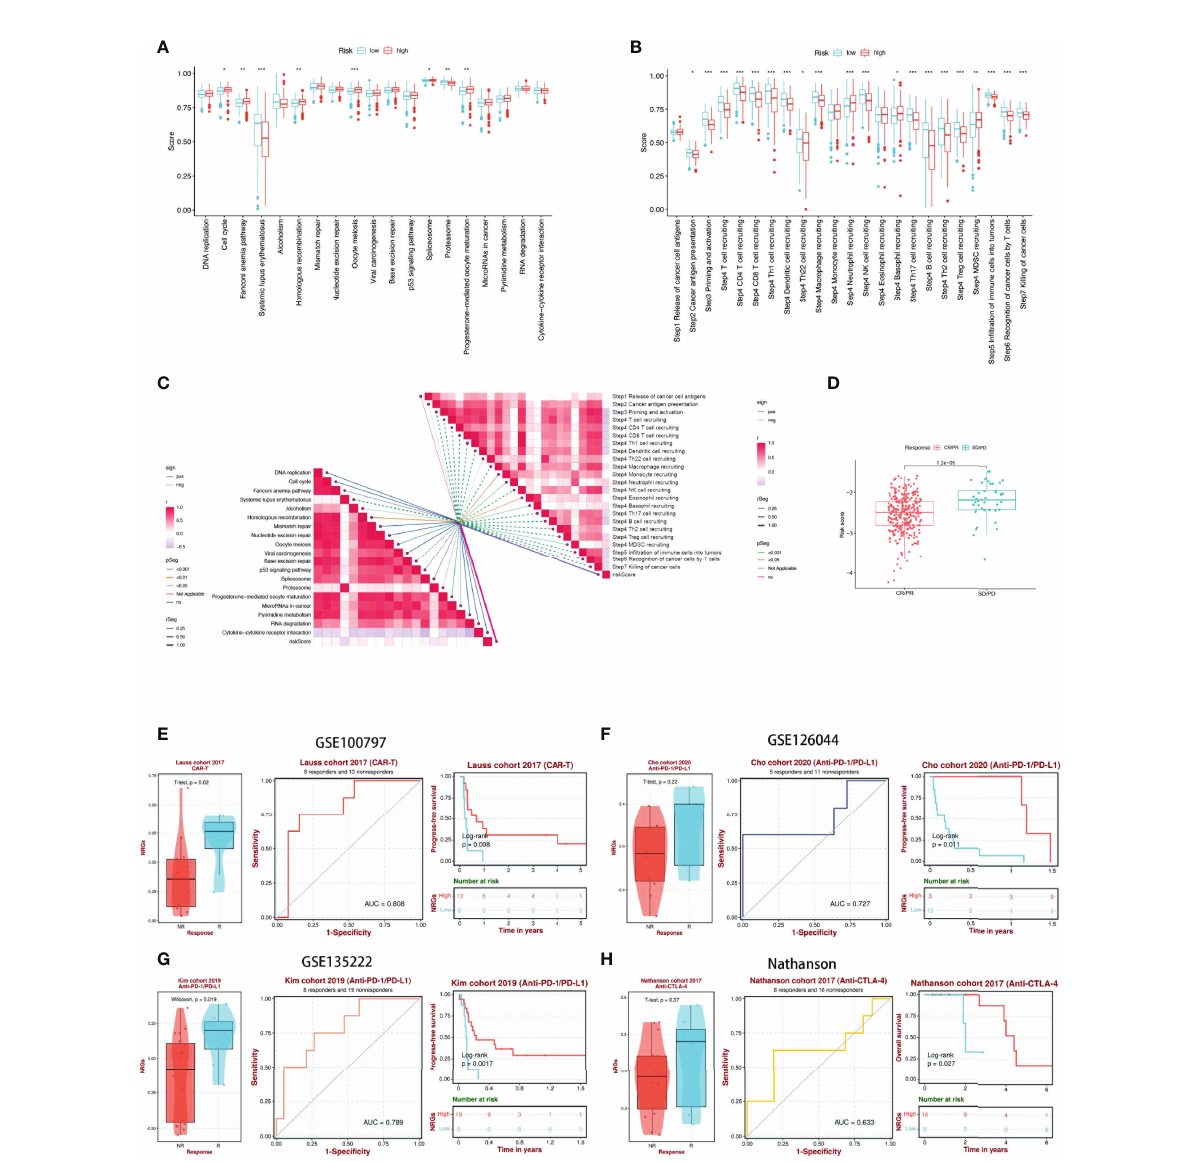
FIGURE 8 17-NRGs risk scores predicting treatment response assessment. (A) The plot of the difference in enrichment scores between the high-risk and low-risk groups on the immunotherapy prediction pathway. (B) The plot of differences between the high-risk and low-risk groups on each step of the cancer-immune cycle. (C) Correlation of risk scores with ICB response signature and each step of the tumor-immune cycle. (D) Correlation between risk scores and clinical response to cancer immunotherapy. (E) Evaluation of NRGs for CAR-T therapy in the GSE100797 cohort. (F, G) Evaluation of NRGs for anti-PD-L1 therapy in the GSE126044 and GSE135222 cohorts. (H) Evaluation of NRGs for anti-CTLA-4 treatment in the Nathanson cohort. PD: disease progression; SD: stable disease; PR: partial response; CR: complete response. TIDE, Tumor Immune Dysfunction, and Exclusion. * P < 0.05, ** P < 0.01, *** P <